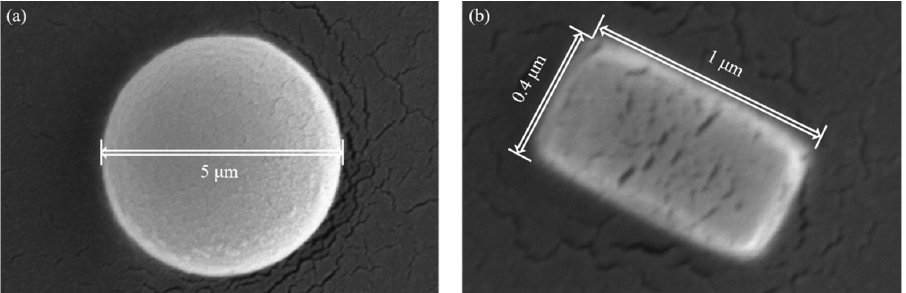
Figure 4. Scanning electron microscope (SEM) image of fluorescent particles. ( a ) Fluorescent microspheres. ( b ) A typical fluorescent micropillar.